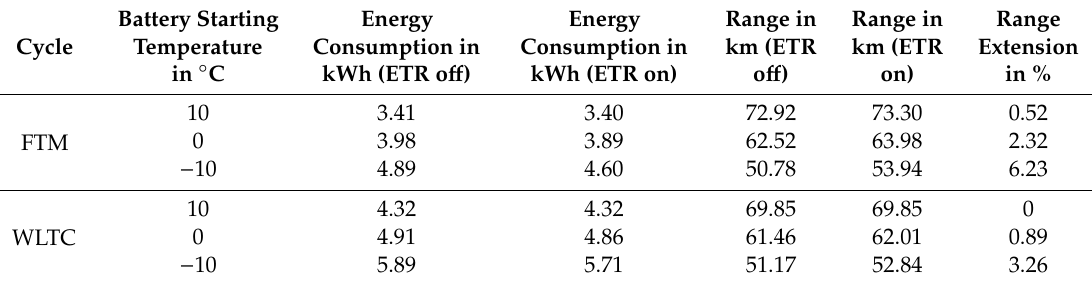
Table 2. Ranges and range extensions for di ff erent battery starting temperatures and a partially charged battery (SoC Start = 60%) for the WLTC and FTM